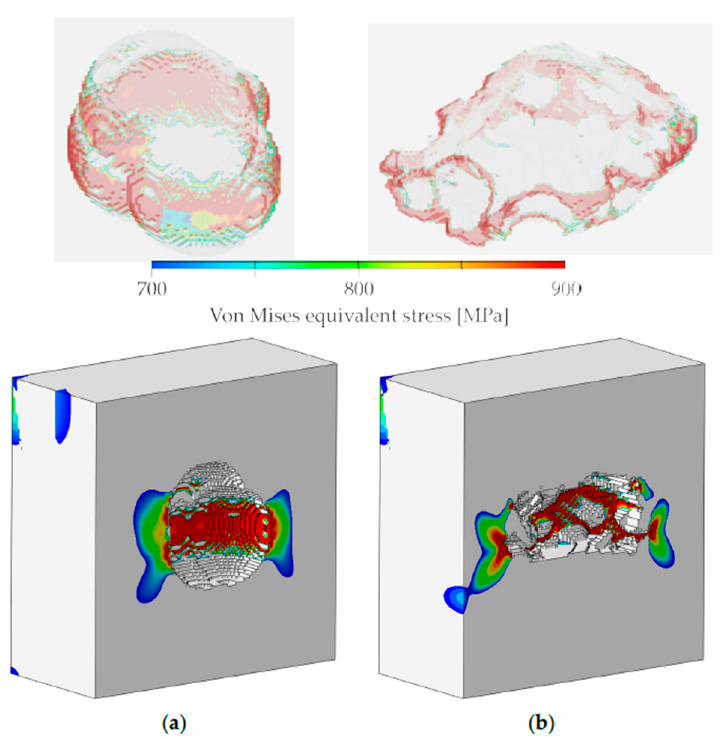
Figure 9. Translucent renderings of the pore domains and cut sections of the analyzed microstructure models with von Mises equivalent stress profiles, illustrating the inhomogeneous distribution of stresses in the vicinity of the embedded pores: ( a ) Circumferential stress profile around the pore with a convex boundary; ( b ) Multiple stress concentrations at the pore with a concave boundary.